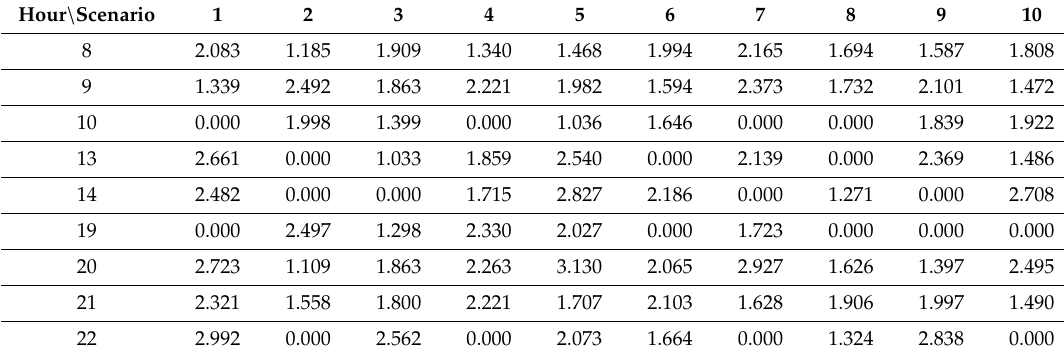
) of the fleet of electric vehicles for Case_1. st